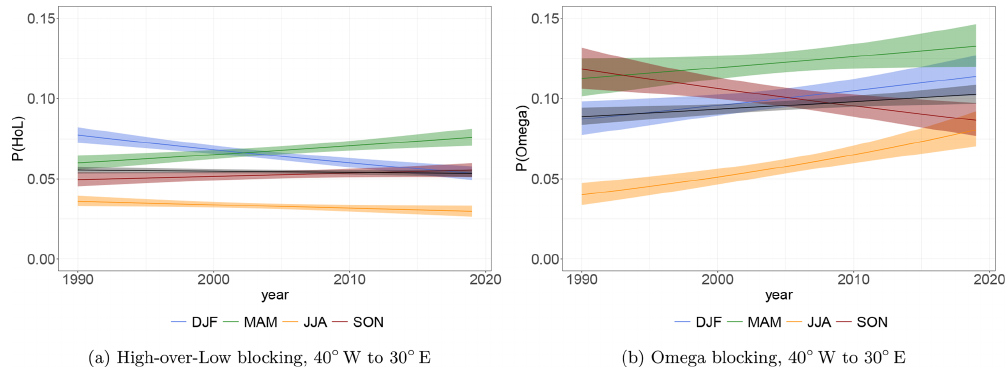
Figure 10. Blocking probability over time for the full year (black line; Eq. 26) and for individual seasons (colored lines; Eq. 27) for the Euro-Atlantic (40 ◦ W–30 ◦ E) region for (a) high-over-low and (b) omega blocking. Shading shows 95% confidence intervals.